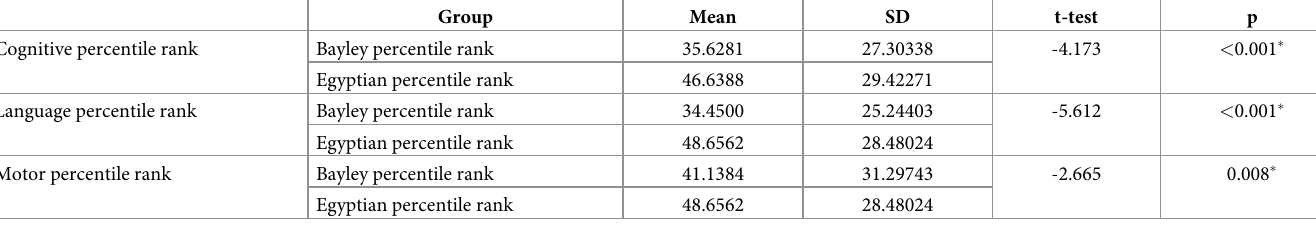
Table 2. Comparison between Bayley percentile rank and percentile of the Egyptian studied